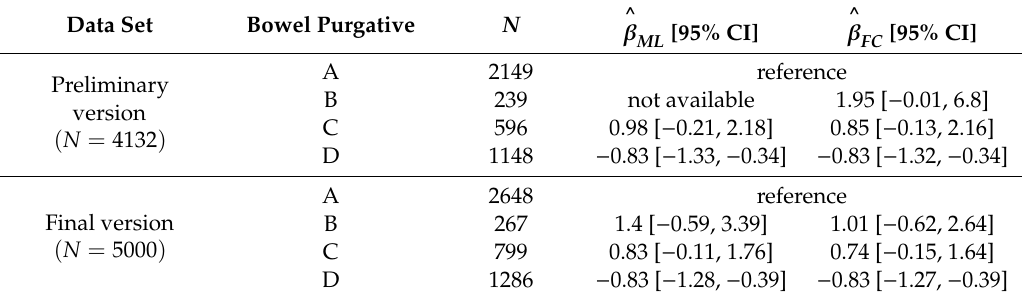
Table 2. Logistic regression coe ffi cient estimates obtained by maximum likelihood (ML) and Firth’s correction (FC) estimation in the preliminary and final analysis of bowel preparation study. All analyses were adjusted for age and sex of the